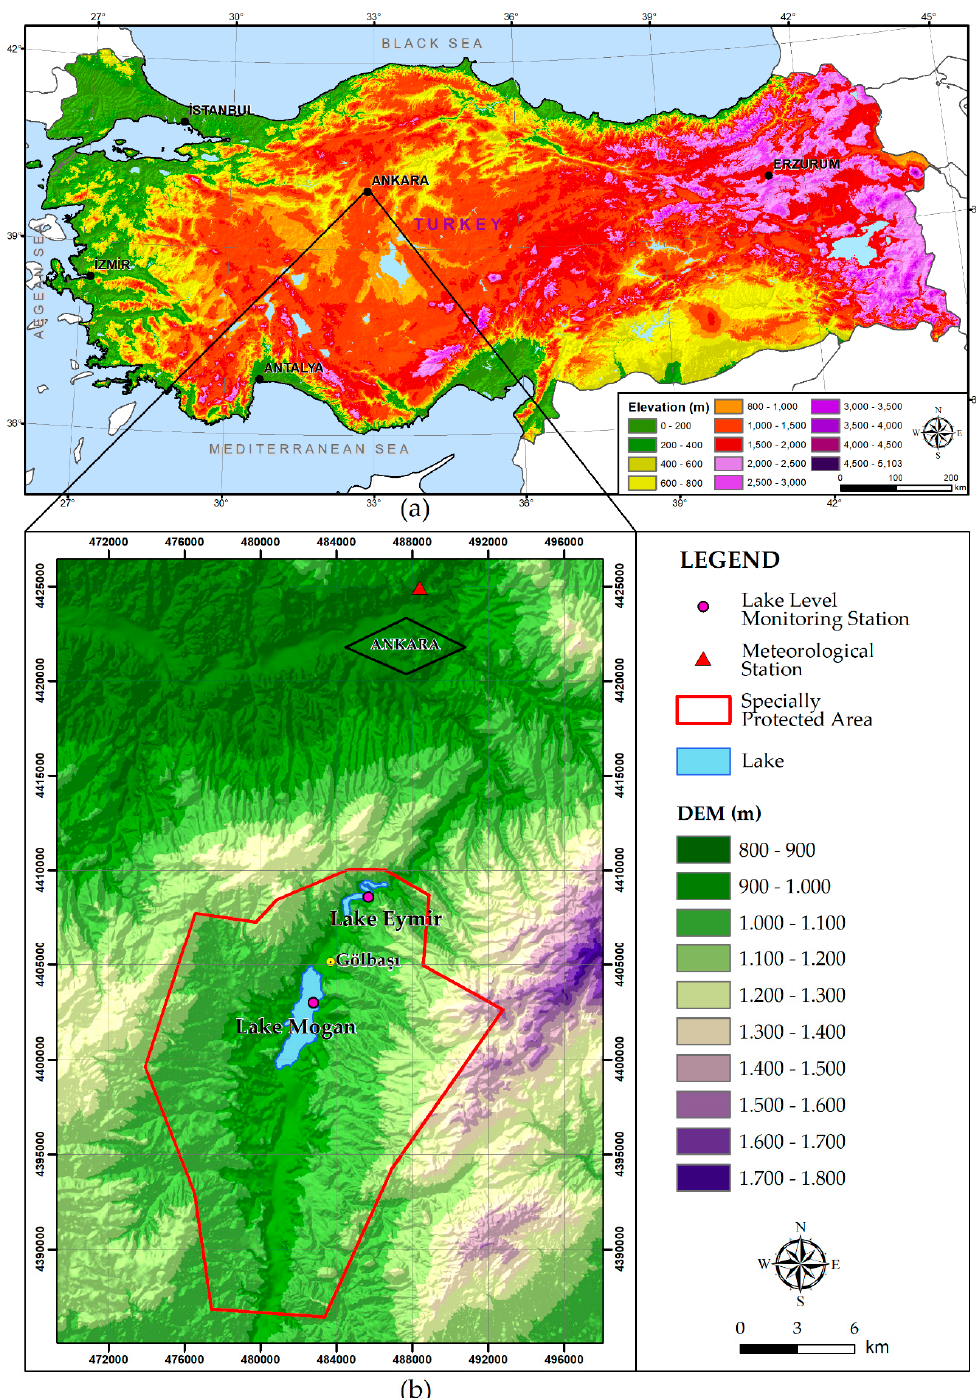
Figure 1. ( a ) Location of the study area. ( b ) Digital elevation map of the study area and location of the monitoring stations.